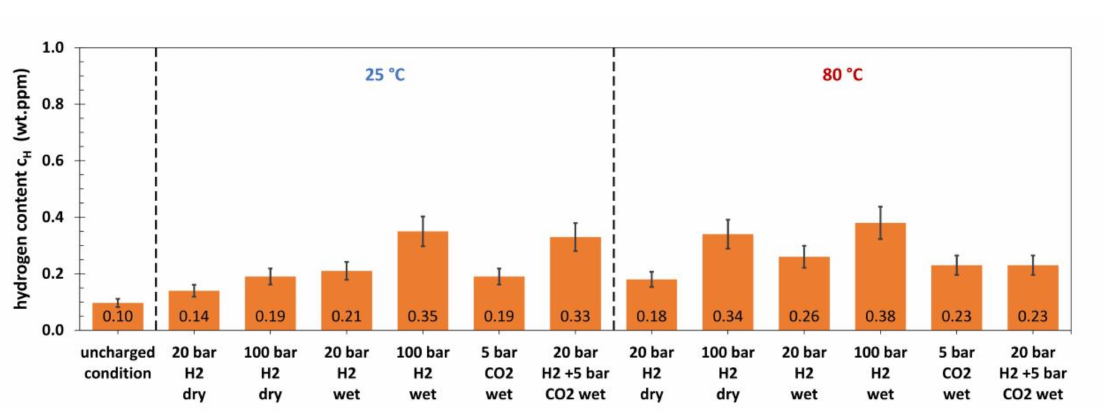
Figure 6. Hydrogen content of P110 after 30 days of autoclave testing with various media at 25 ◦ C and 80 ◦ C (wet conditions: with electrolyte; 15,000 ppm Cl − ).